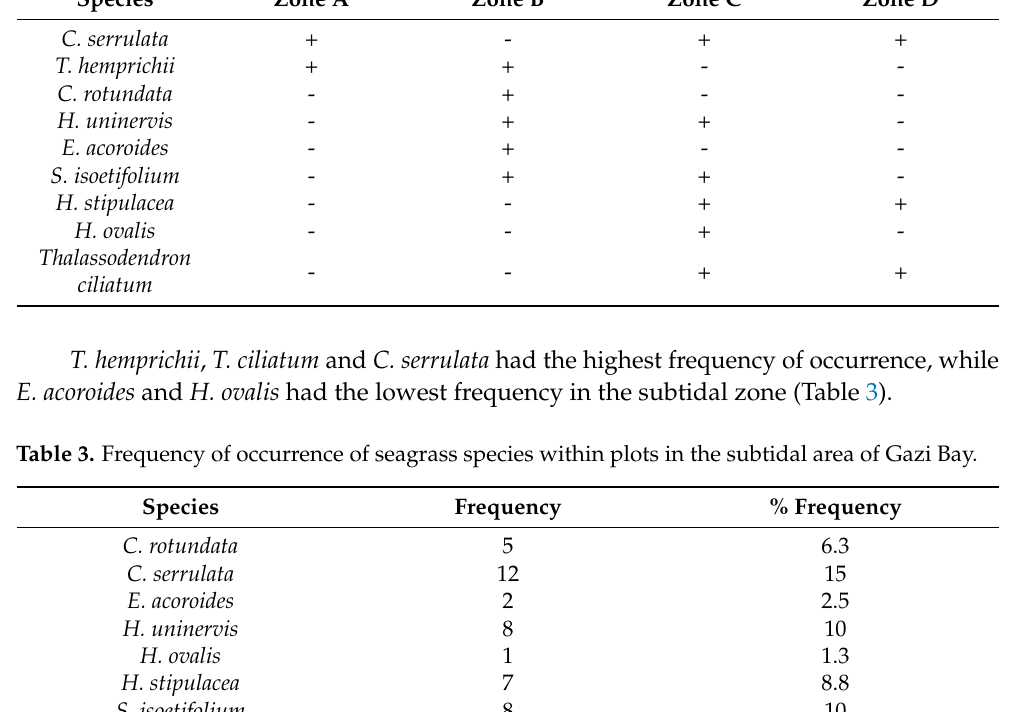
Table 2. Distribution of seagrass species in the subtidal zone, + = presence, - = absence. Species Zone A Zone B Zone C